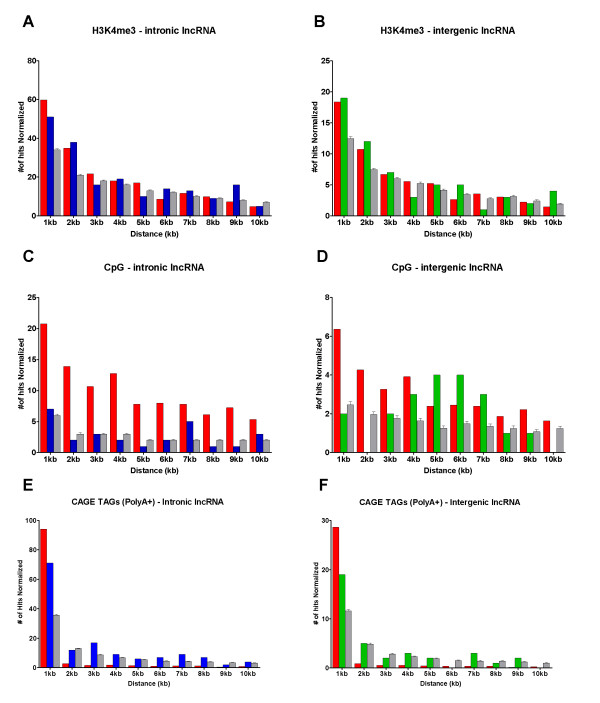
Genomic loci encoding intronic lncRNAs are enriched in promoter-associated histone marks and start sites of capped transcripts. Distance distribution (X axis) of promoter-associated chromatin marks H3K4me3 binding sites (panels A, B), CpG islands (panels C, D) and CAGE Tags (panels E, F) relative to genomic coordinates of intronic (blue bars) and intergenic (green bars) transcripts expressed in pancreatic tissues (Y axis) were calculated. For comparison, distribution distances were calculated for an equal number of protein-coding mRNAs (red bars) and for randomly selected intronic or intergenic genomic sequences with the same length and % GC of pancreas expressed lncRNAs (light gray bars).